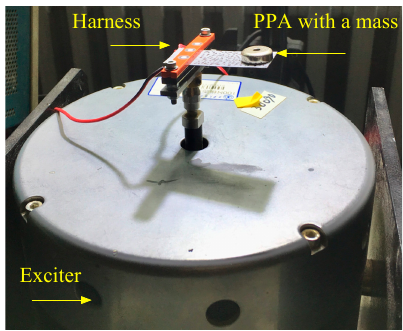
Figure 3. PPA clamped to the exciter .